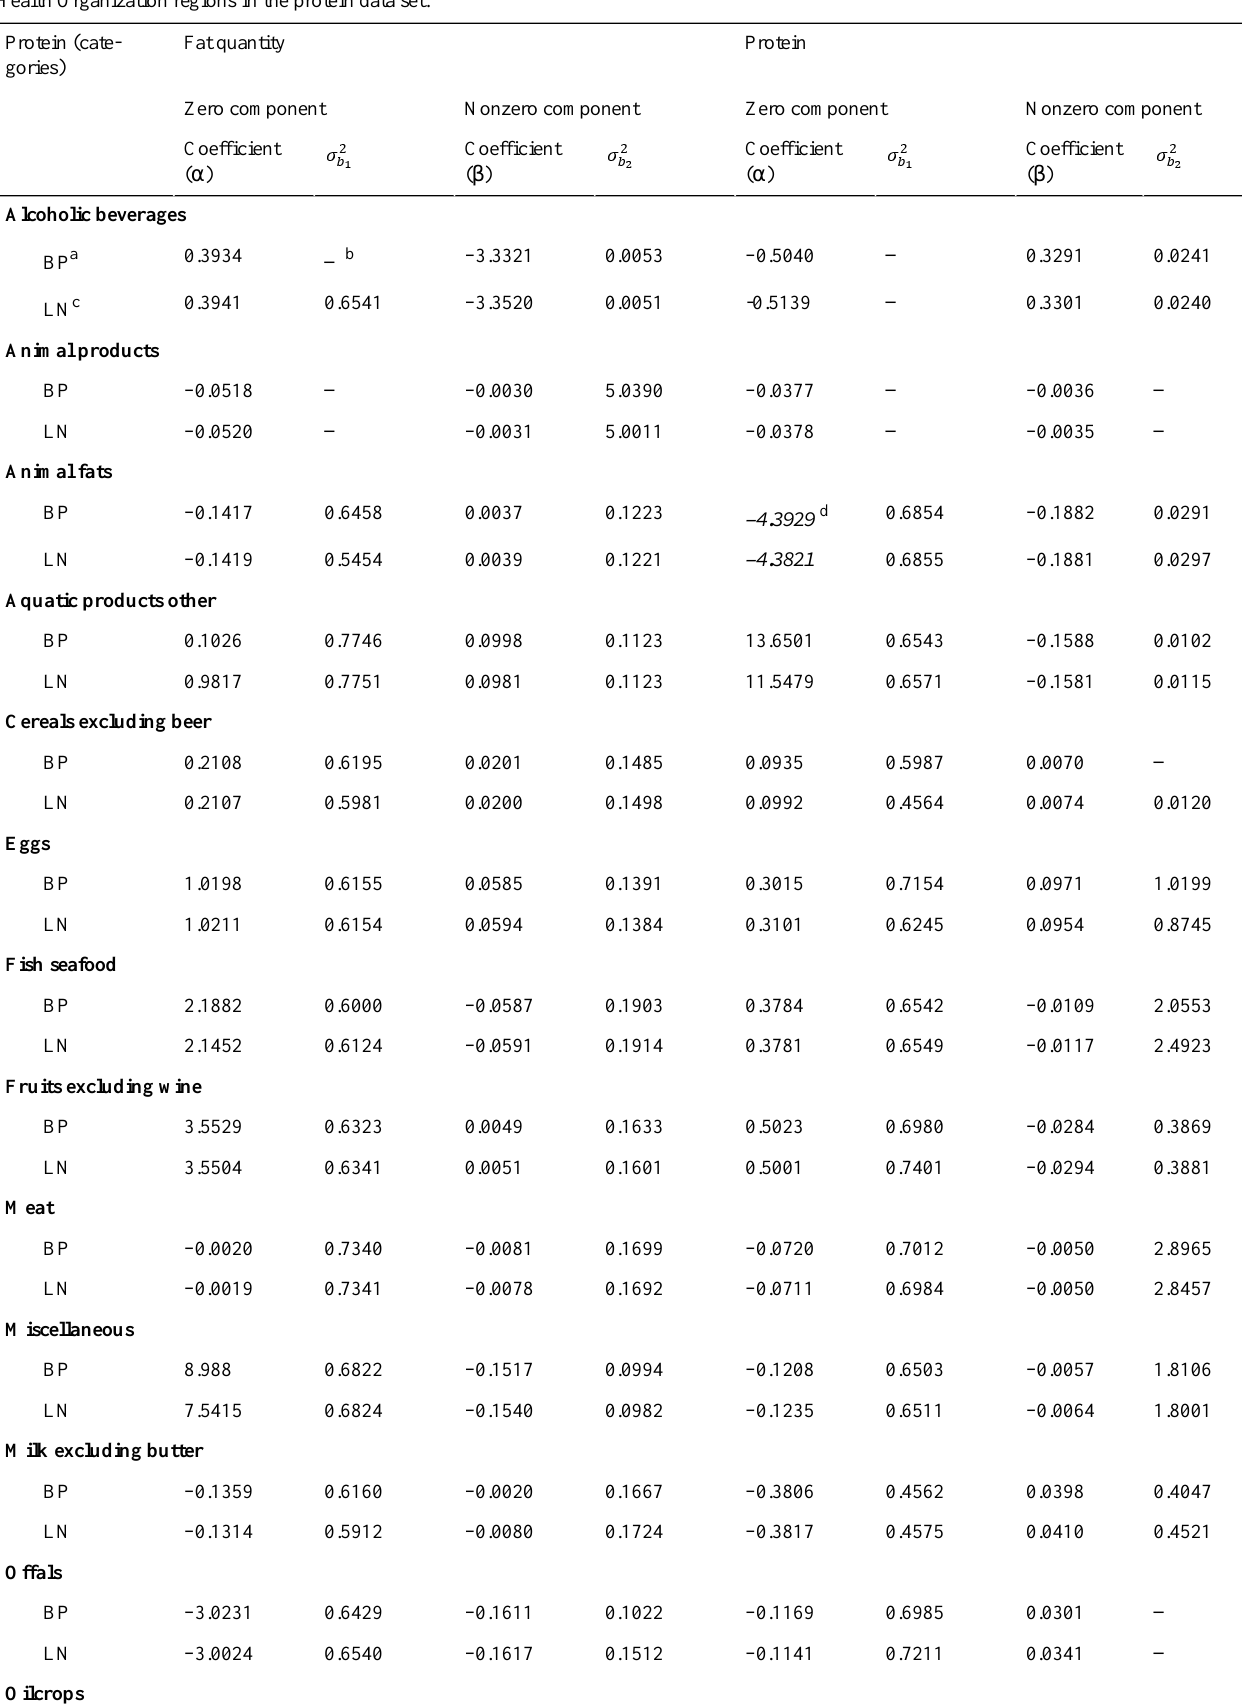
Table 2. Results of marginalized two-part BP and LN model in predicting number of deaths in 100 cases and considering the cluster effect of World Health Organization regions in the protein data